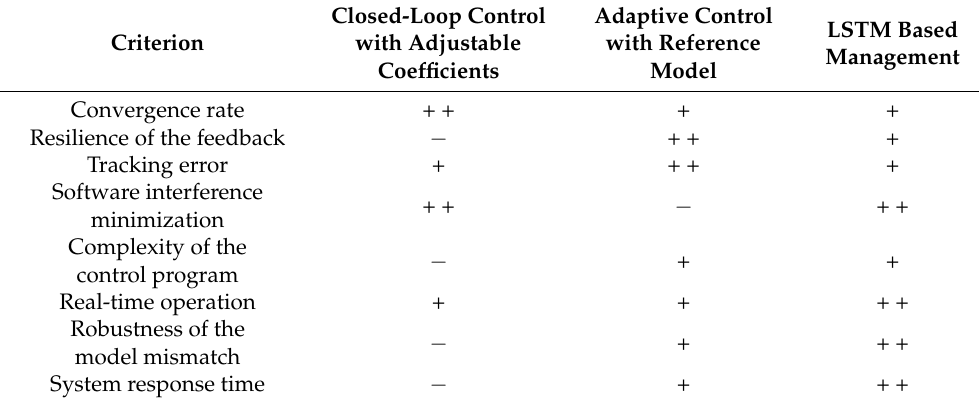
Table 3. The results of the comparative analysis of the management